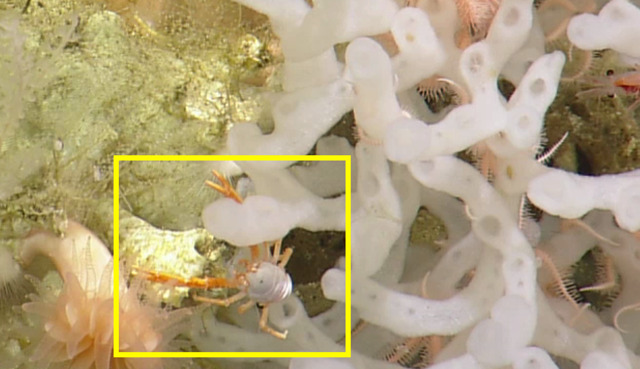

Munidopsis
mina